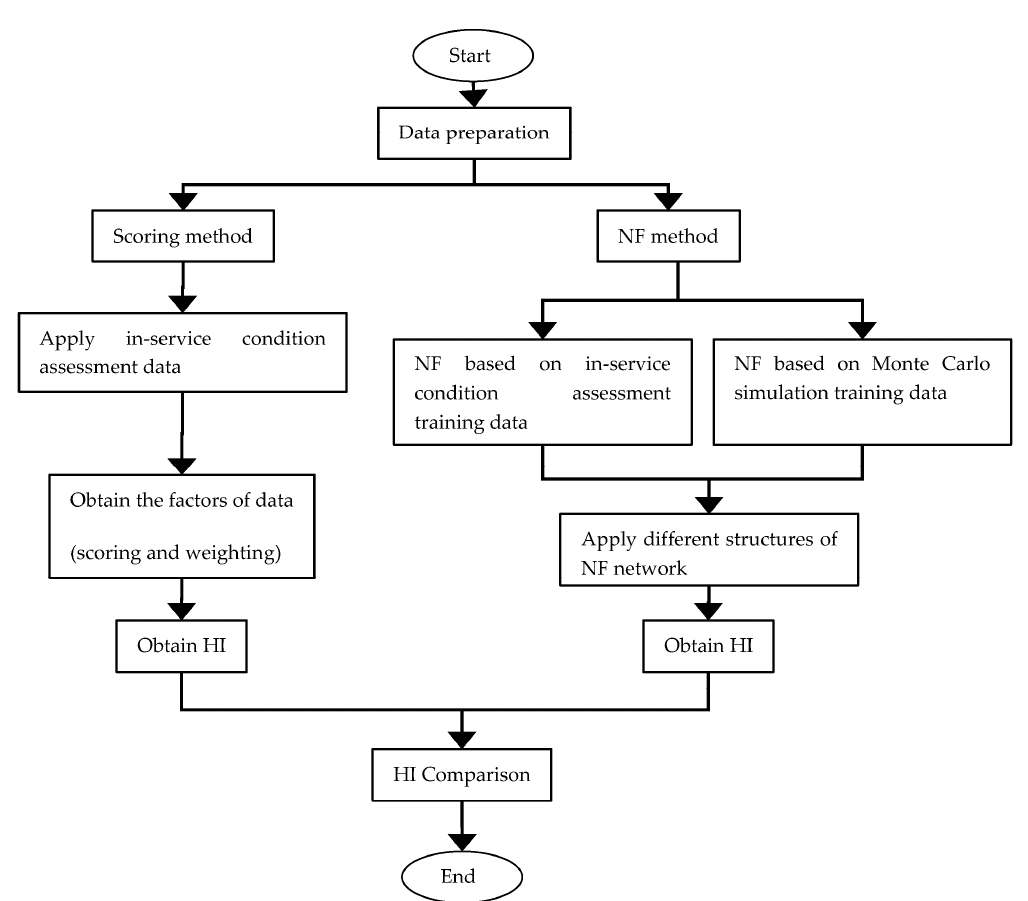
Figure 1. Workflow of the study. HI: health index; NF: Neural-Fuzzy.